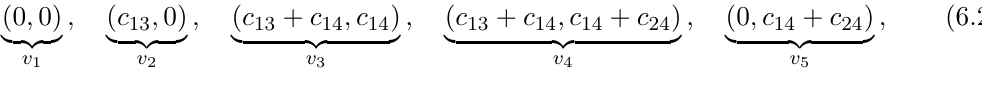
and X , having 1 , 3 1 , 4